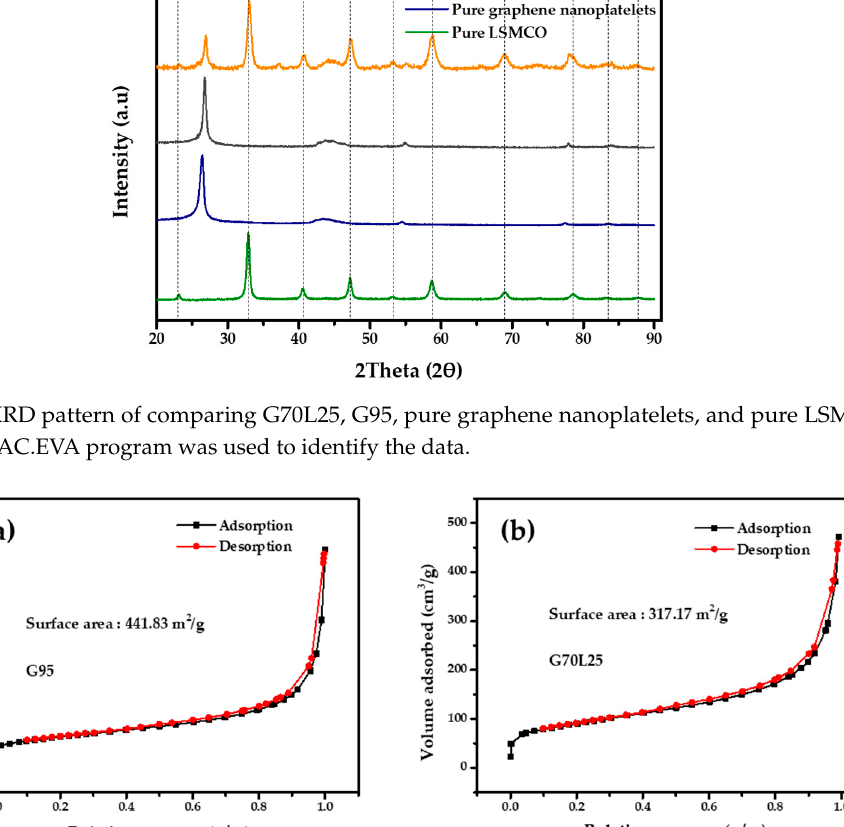
Figure 2. XRD pattern of comparing G70L25, G95, pure graphene nanoplatelets, and pure LSMCO; The DIFFRAC.EVA program was used to identify the data.